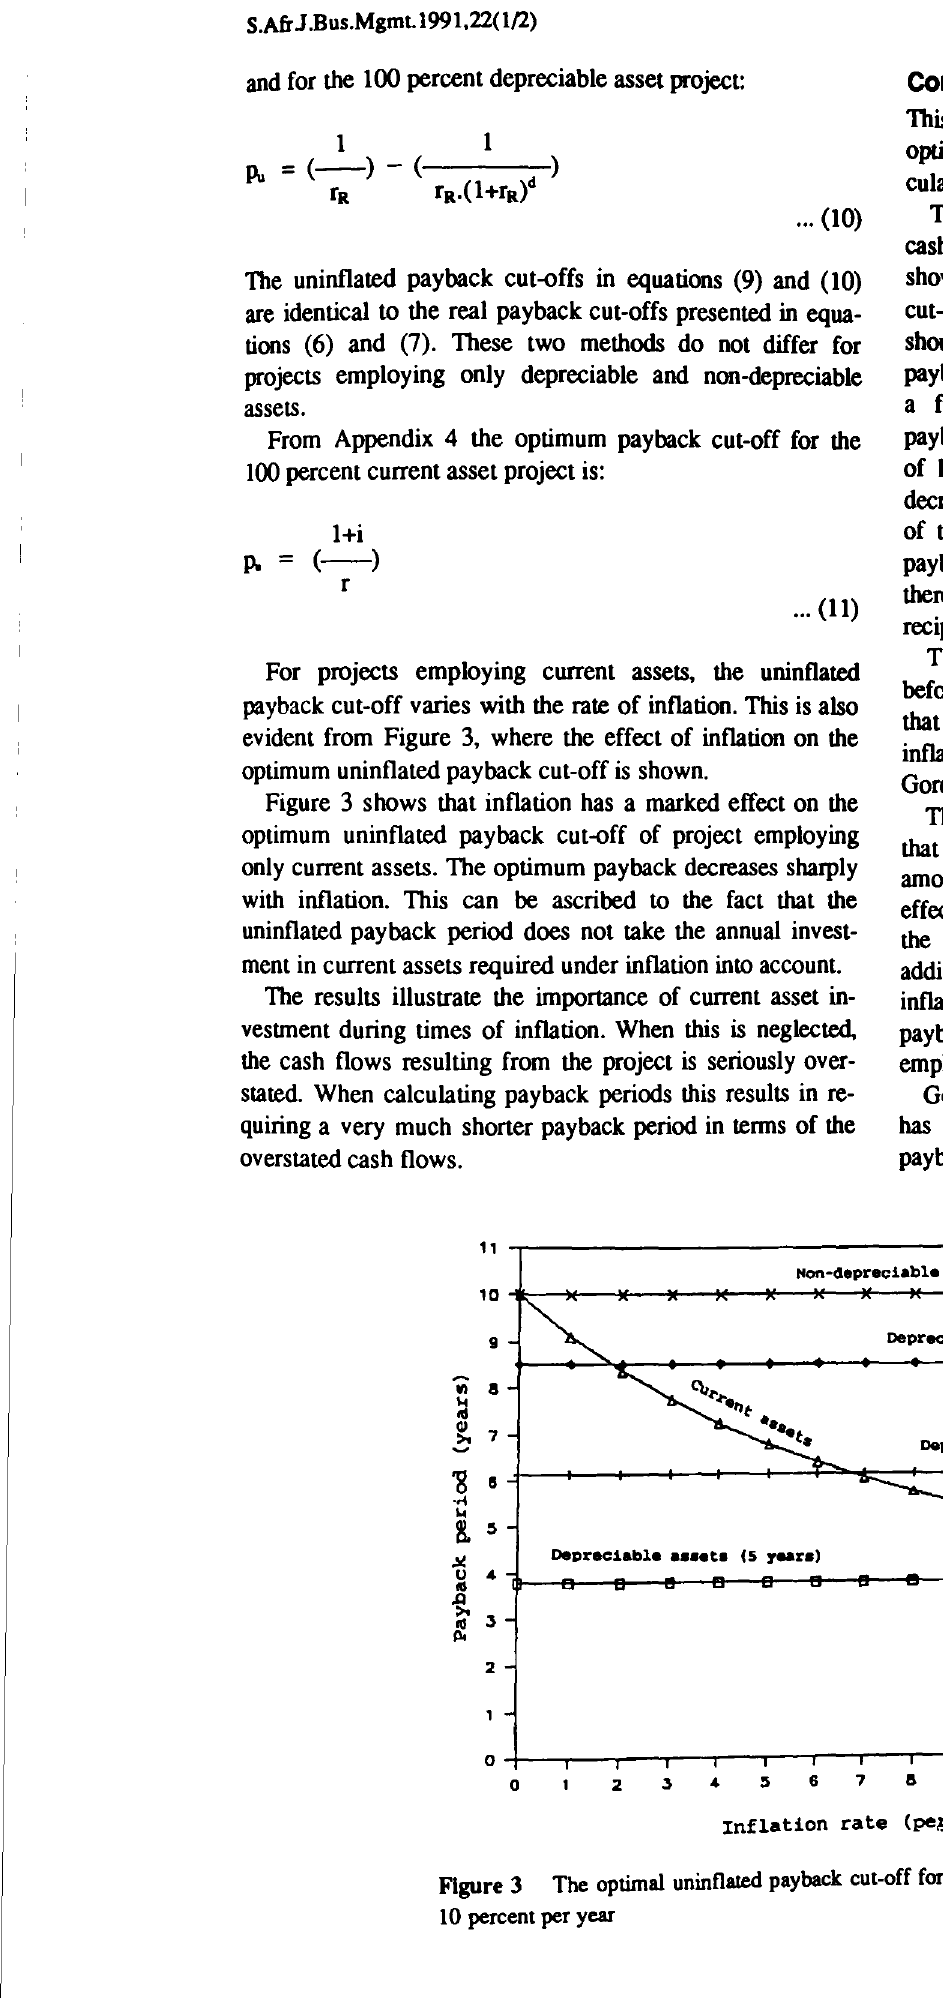
Inflation rate (peicent per year) Figure 3 The optimal uninflated payback cut-off for projects with a required real return of 10 percent per